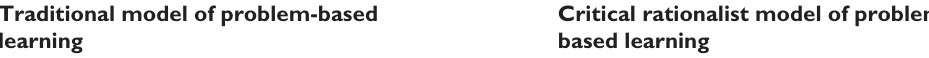
Critical rationalist model of problem- based learning Knowledge is from within. And problems are